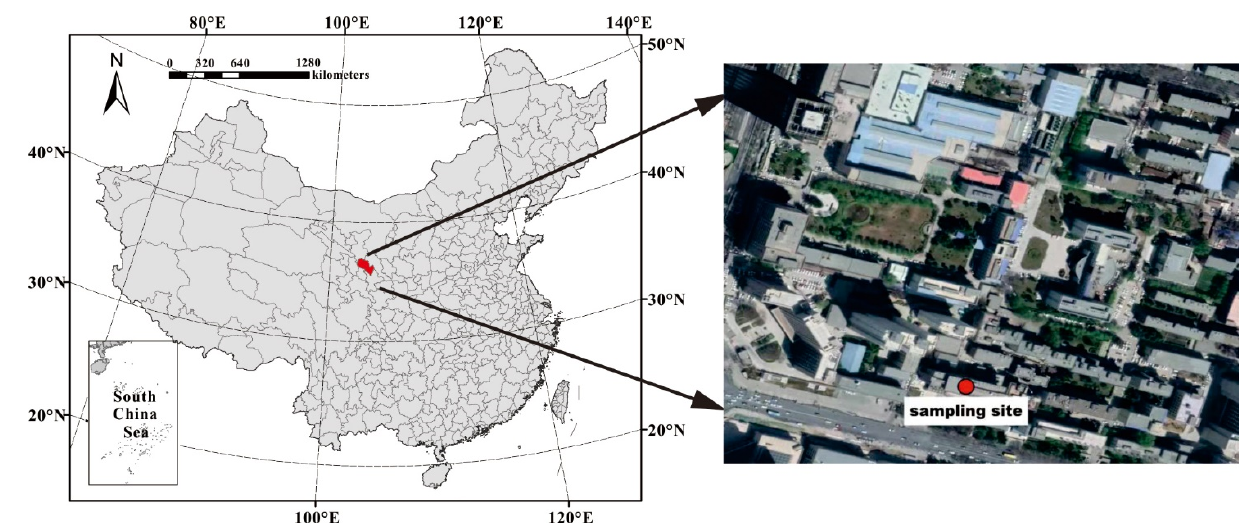
Figure 1. Location of the sampling site.